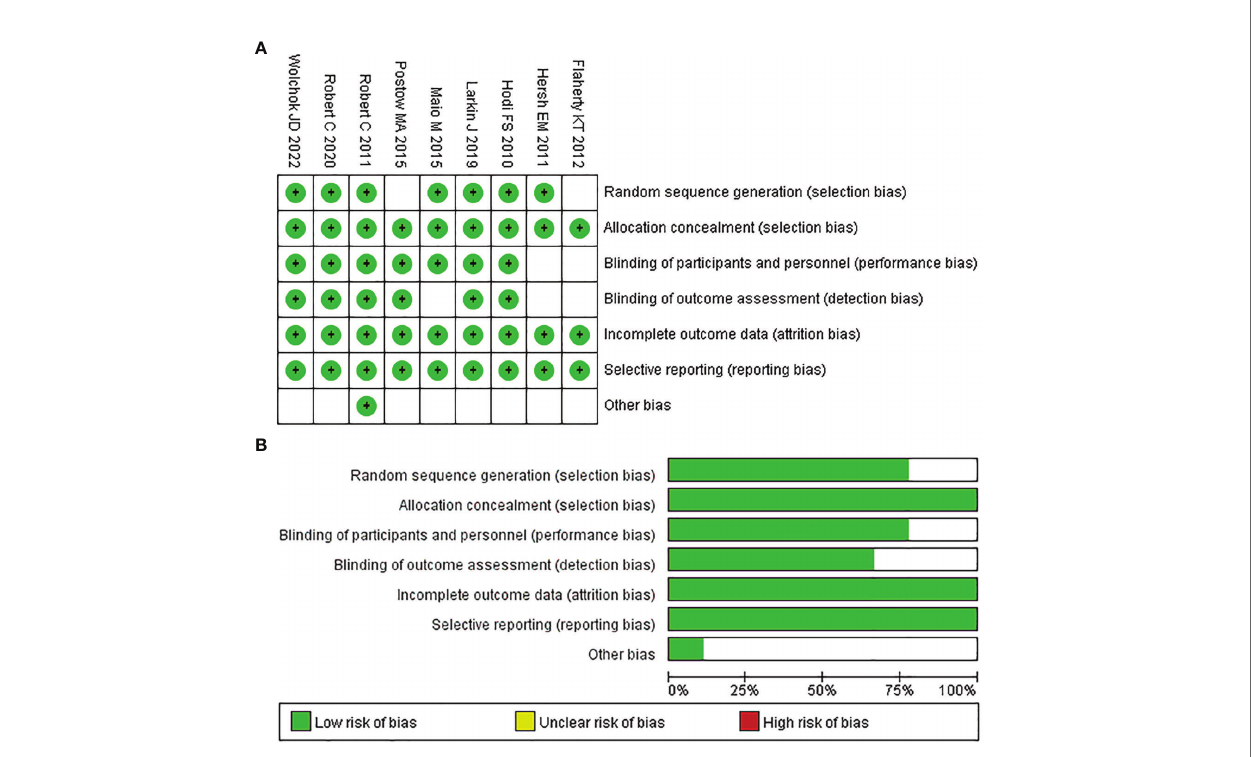
FIGURE 2 | Quality assessment of included trials in the NMA. Risk of bias summary (A) and Risk of bias graph (B)